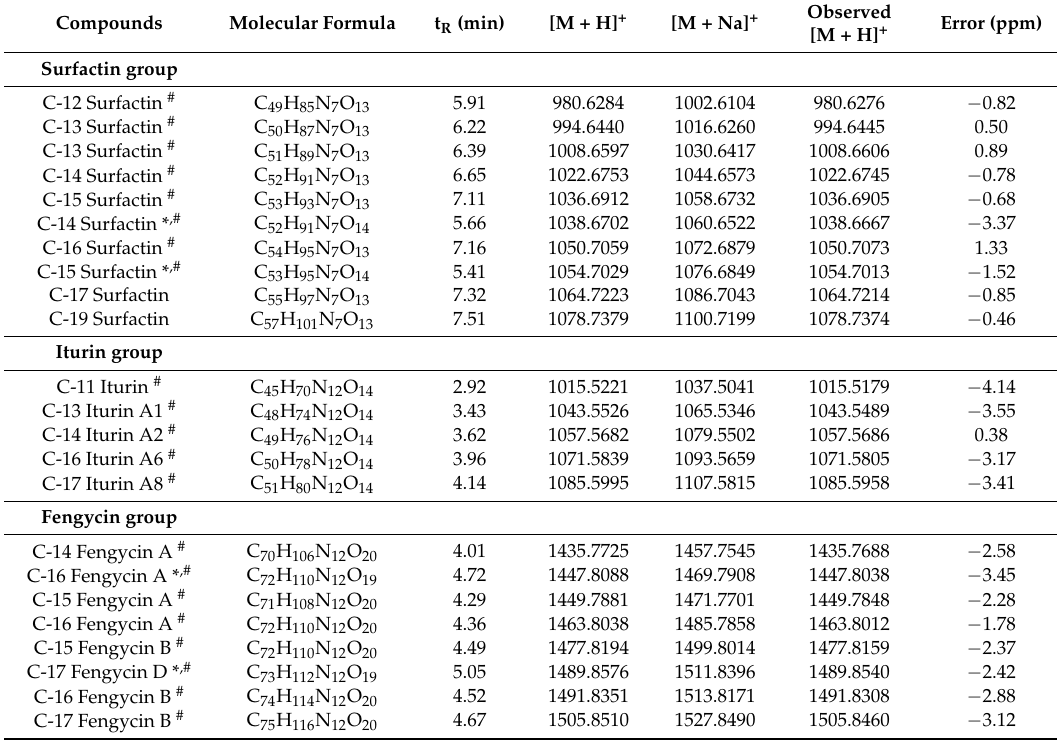
Table 1. Lipopeptide composition of Ba-BPD1 analyzed by LC-ESI